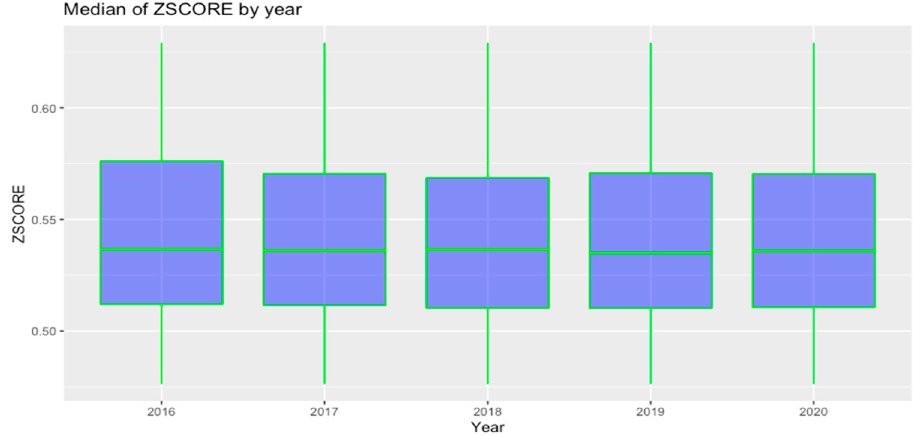
Figure 4. Median of bankruptcy risk coefficient (ZSCORE) by year (source: compiled from data processing by the authors).